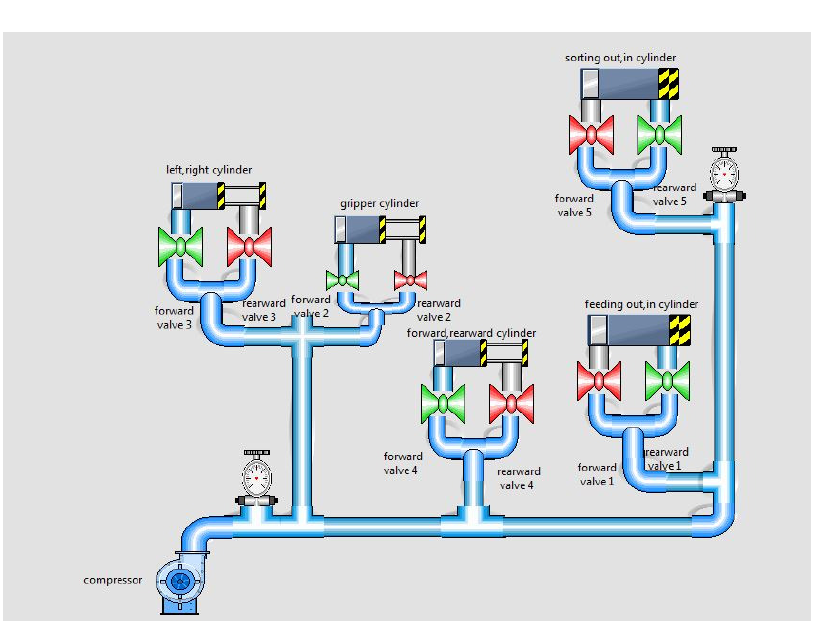
Fig. 17. Two HMI result robotic arm started . 3- The robotic arm moved to right side (right cylinder set and right cylinder reset). When the robotic arm got to right side the gripper unclamped the work piece (the unclamping cylinder set and